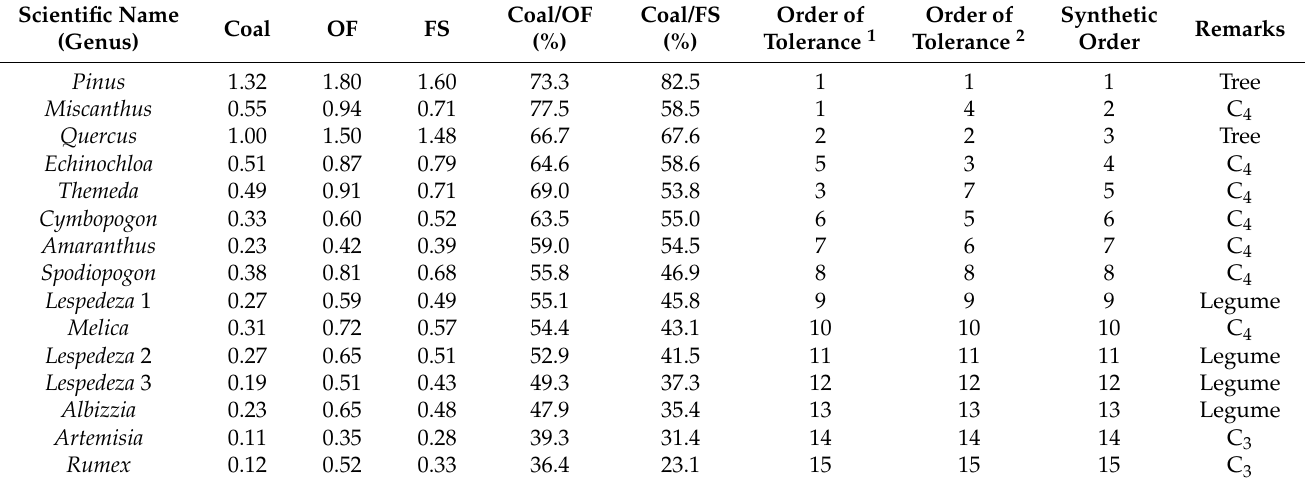
Table 3. Growth coefficient in each plot, ratio of growth coefficient to the ameliorated plot, and the order of tolerance to the raw coal mine debris. Coal: raw coal mine debris plot, OF: plot ameliorated treating organic fertilizer of 12.8 ton/ha, FS: plot ameliorated covering forest soil of 10 cm